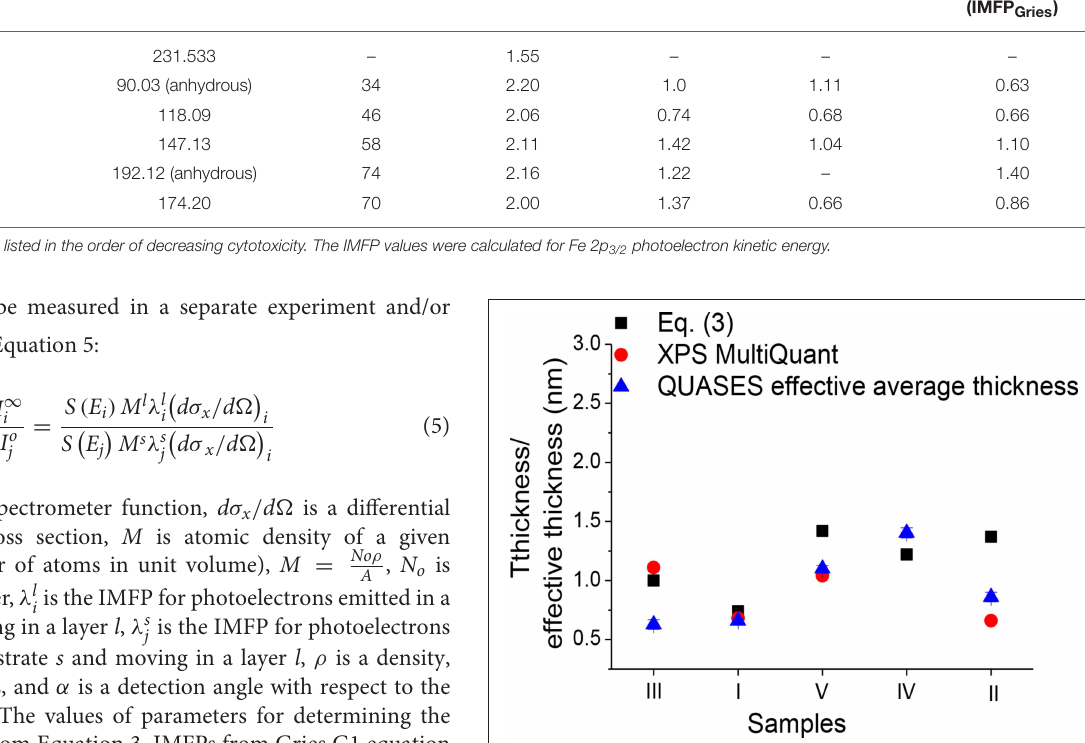
FIGURE 9 | Comparison of overlayer thickness resulting from attenuation equation (Equation 3) (solid square), XPS MultiQuant (solid circle), and effective average thickness resulting from QUASES-Analyze (solid triangle) for Fe 3 O 4 f-MNPs I–V. Sample f-MNPs I–V are shown in the order of decreasing cytotoxicity.